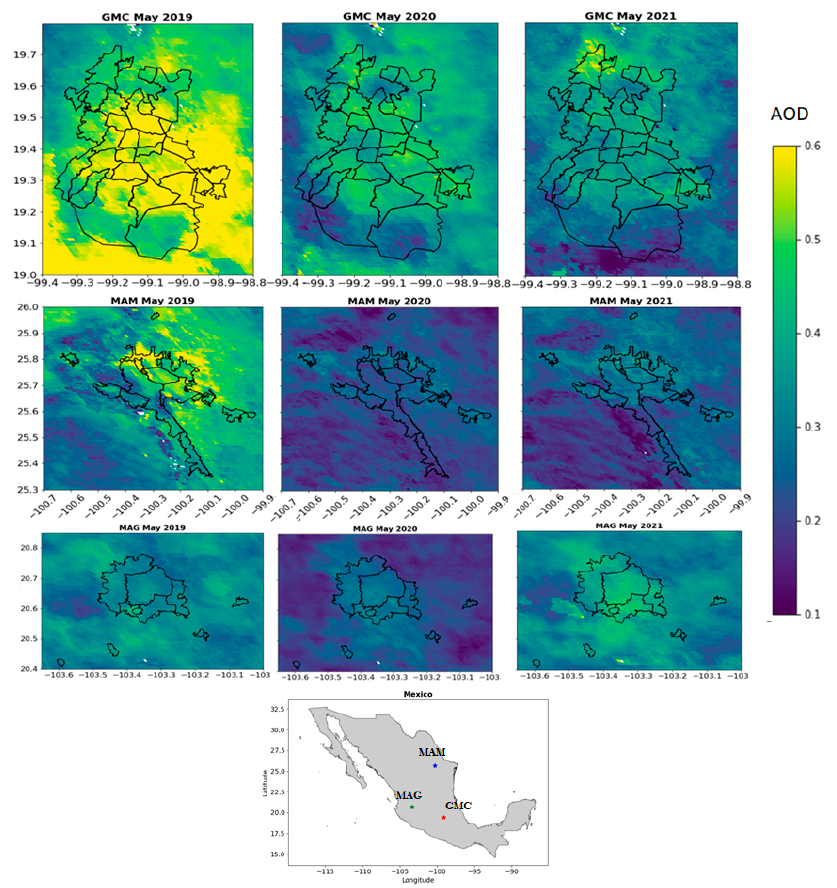
Figure A1. AOD distribution in GMC, MTY, and MAG in May 2019–2021. Surface wind maps.